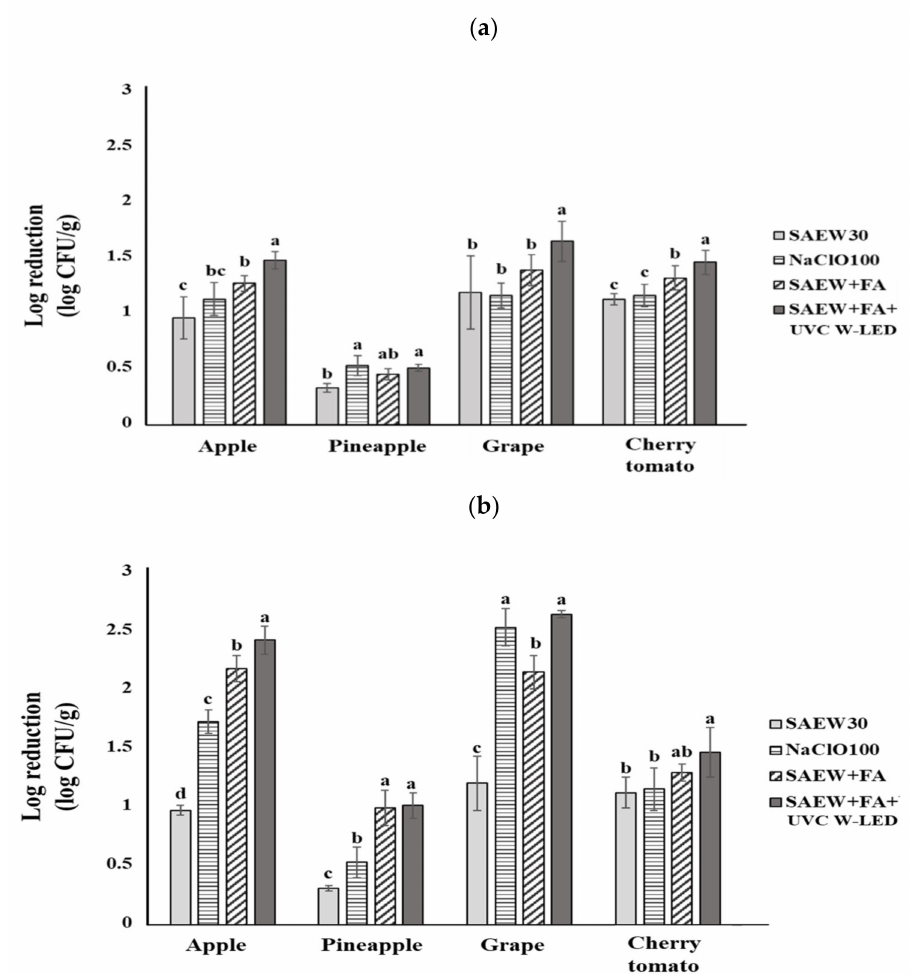
Figure 1. Reduction effect of ( a ) S. aureus and ( b ) L. monocytogenes after disinfection treatments in various fruits. NaClO, sodium hypochlorite solution (control, 100 ppm); SAEW, slightly acidic electrolyzed water (30 ppm); FA: fumaric acid (0.5%); UVC W-LED: ultravioletC waterproof light-emitting diodes (275 nm). a–d values within each fruit represent differences by using Duncan’s multiple-range test at p <